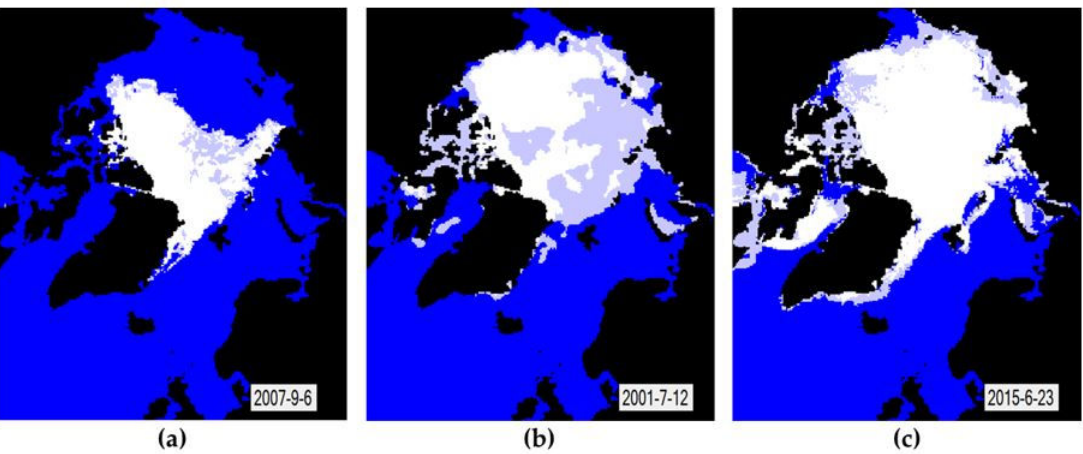
Figure 3. Distributions with di ff erent sea ice extent ( SIE ), mean, standard deviation ( std ), and correlation values ( cor ): ( a ) Sea ice distribution with SIE = 3914375, meanX t = 123.4, meanY t = 174.3, stdX t = 27.1, stdY t = 26.5, corXY t = − 0.35; ( b ) Sea ice distribution with SIE t = 9048750, meanX t = 127.4, meanY t = 187.9, stdX t = 40.4, stdY t = 36.8, corXY t = 0; ( c ) Sea ice distribution with SIE t = 9706875, meanX t = 117.6, meanY t = 181.6, stdX = 46.9, stdY = 41.1, corXY = t t t